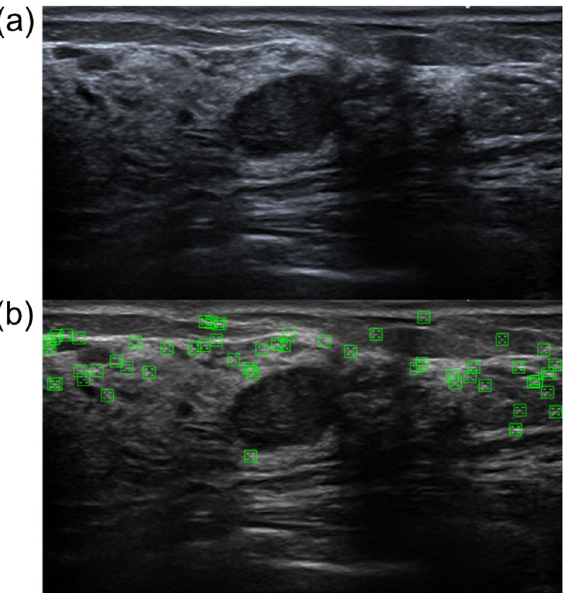
Figure 3. Visualised extracted feature vector from a malignancy US image by Histogram of Oriented Gradient (HOG). The moderate suspicion for malignancy (BI-RADS category 4B) case: female, age 51 years, an irregular and vascularised mass was found at the left breast and reported by ultrasound imaging, size: 1.2 × 0.9 cm, location: 1–2 o’clock from the nipple, distance: 6 cm from the nipple. A Core needle biopsy was performed and confirmed ductal carcinoma in situ. The infiltrating ductal carcinoma was confirmed after a partial mastectomy, size: 2.2 × 1.6 × 0.9 cm. The sentinel lymph node dissection was negative for malignancy at the left (0/2), and the immunohistochemical study of cytokeratin shows no metastatic carcinoma cells. The extracted feature vectors through the HOG descriptor from the image are shown as corner points. ( a ) The US image of this case. ( b ) Green marks represent the corner point positions obtained from the accelerated segment test